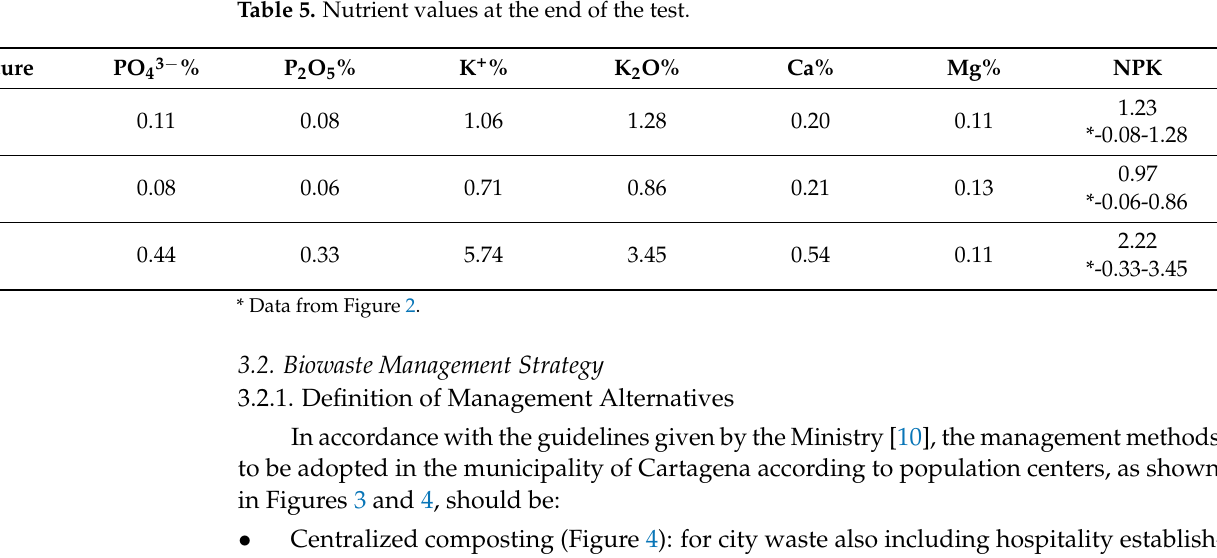
Table 5. Nutrient values at the end of the test.